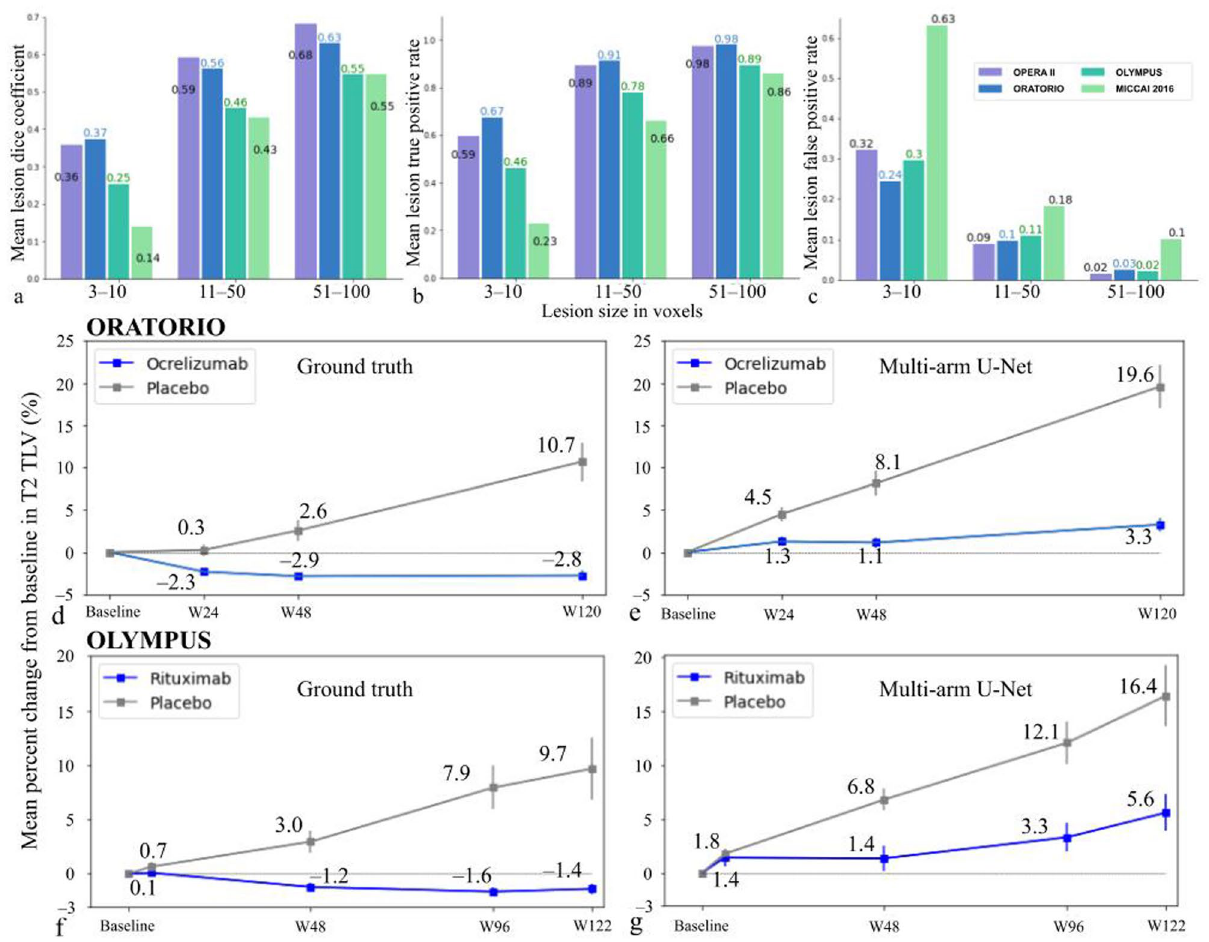
Figure 3. T2 lesion detection performance for different lesion size groups and reproduction of secondary imaging endpoint on T2 TLV. Bar plots of mean lesion DC ( a ), mean lesion true positive rate ( b ) and mean lesion false positive rate ( c ) of T2 lesion detection of the proposed multi-arm U-Net for the three smaller lesion size groups. The performance was similar in OPERA II and ORATORIO trials, whilst it was slightly reduced for the OLYMPUS trial and further reduced for the MICCAI 2016 dataset, which could be attributed to differences in MRI acquisition and annotation styles. Across the various datasets, lesion detection performance improved with increase in lesion size. Percent change in T2 TLV from baseline to Week 120 was a secondary imaging endpoint in the ORATORIO trial. This endpoint was reproduced by using either GT masks ( d ) and multi- arm U-Net predicted masks ( e ) in the ORATORIO trial, showing similar separation between the ocrelizumab and placebo arms. Longitudinal trends from a similar analysis of the OLYMPUS trial using GT masks ( f ) and predicted masks ( g ) exhibited similar relative separation between the rituximab and placebo arms. The shift in the mean values may be due to the false positives and false negatives in the model predictions. DC, dice coefficient; GT, ground truth; TLV, total lesion volume; w, week.